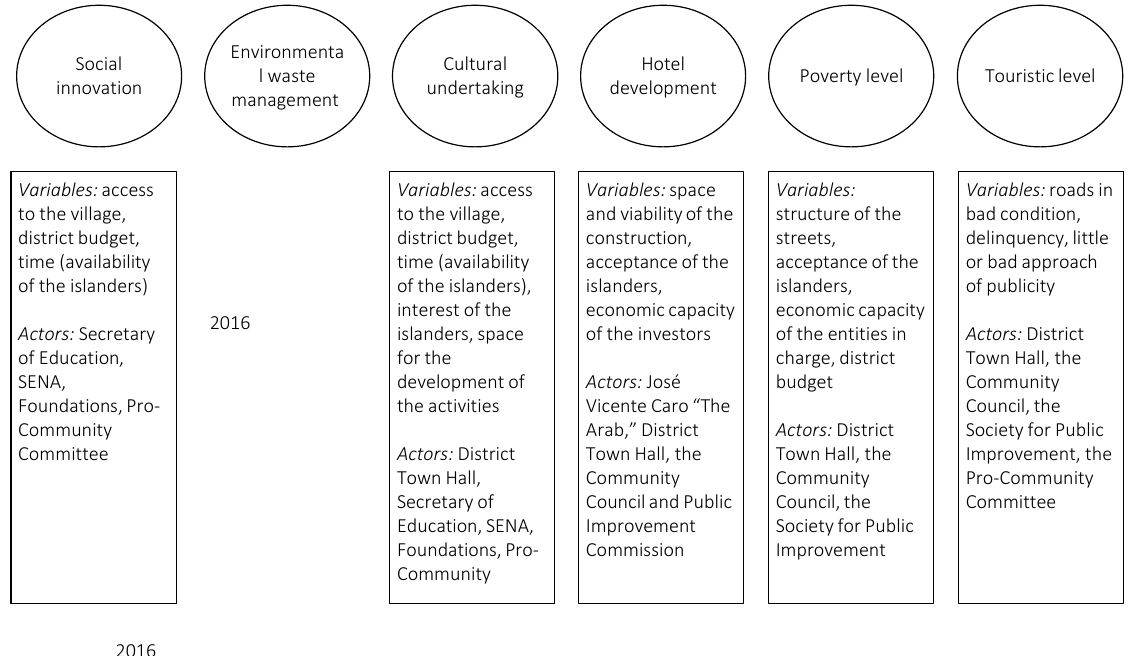
Figure 5. Alternative scenario: 1 0 1 1 1 1. Probability of occurrence of 5.60%